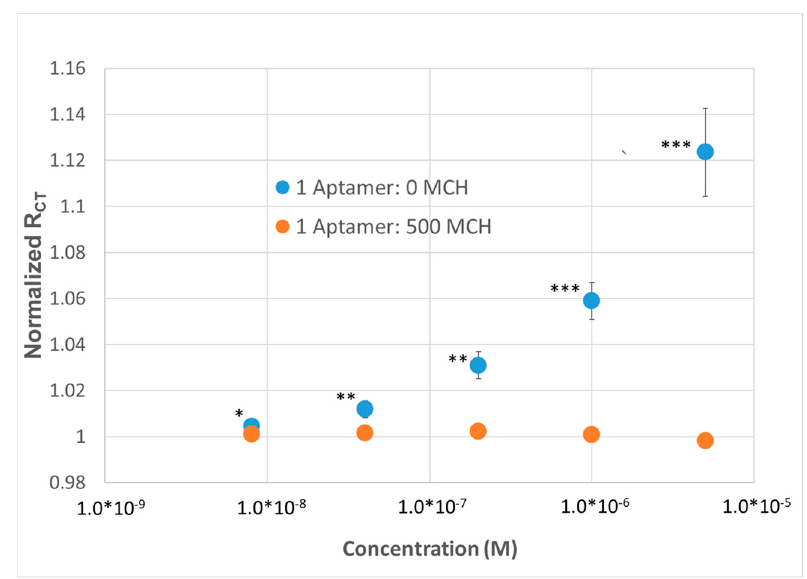
Figure 3. Demonstration of lysozyme aptasensor (n = 4) using EIS using a dense, thick SAM (1:Aptamer: 0 MCH) and a diffuse SAM (1 Aptamer: 500 MCH). P values < 0.05 (*), 0.01 (**) and 0.001 (***) determine using a two-tail t-test.